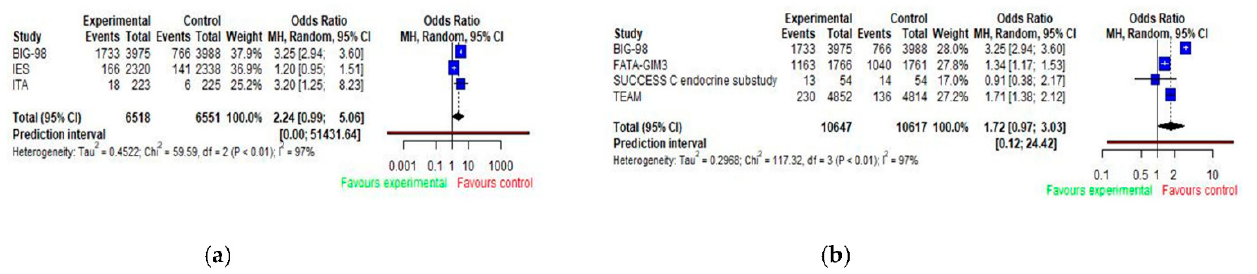
Figure 6. Forest plot of odds ratios for dyslipidemia with AIs by trial design ( a , b ). E (experimental group); C (control group). ( a ) E: AIs (monotherapy) or AIs + tamoxifen (sequence) vs. C: tamoxifen (monotherapy); ( b ) E: AIs (monotherapy) vs. C: AIs + tamoxifen (sequence) or tamoxifen (monotherapy).